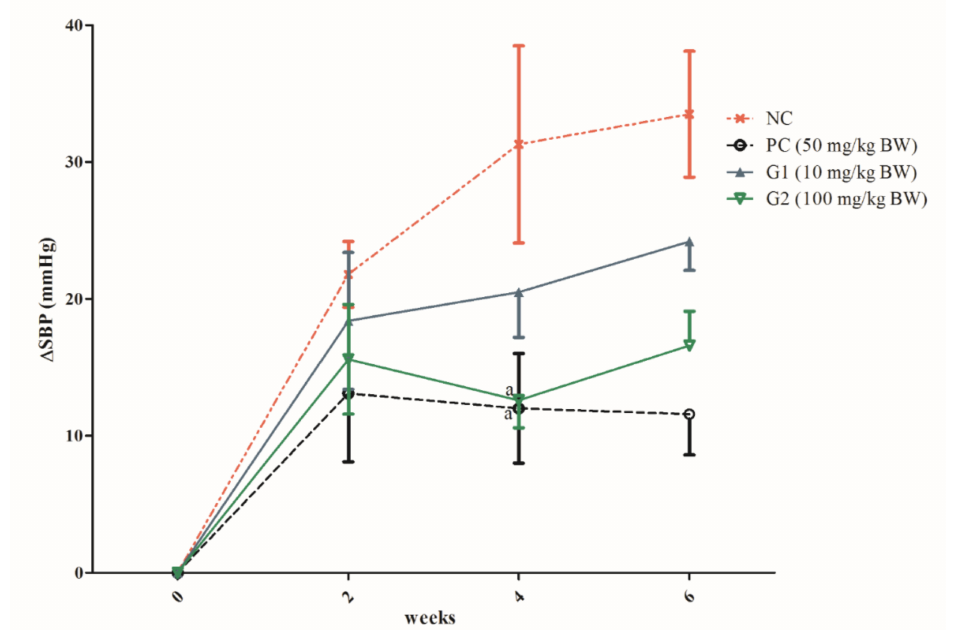
Figure 4. Systolic blood pressure changes from the baseline are expressed in absolute values (mmHg) and data are mean ± SEM from 5 determinations. Data points with the same alphabets are not significantly different ( a p > 0.05) using one-way ANOVA followed by Duncan tests. NC: Negative control, PC: Positive control, G1: Group 1, G2: Group